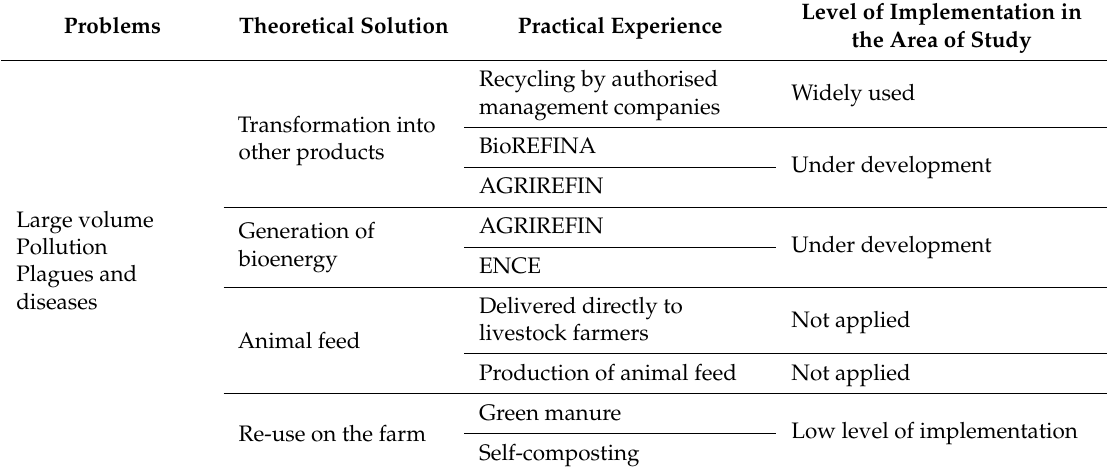
Table 3. Main solutions based on the Circular Economy (CE) for plant